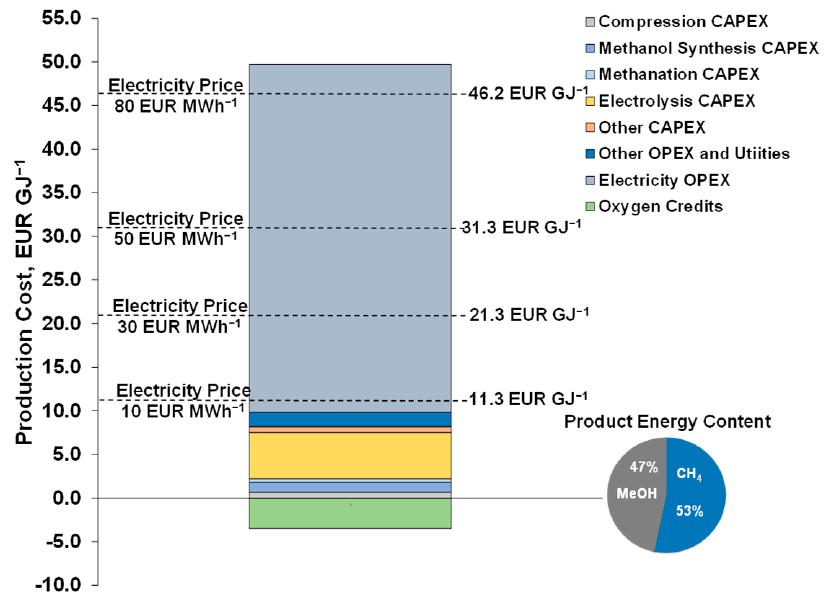
Figure 18. Production cost breakdown and effect of electricity price of the combined case.